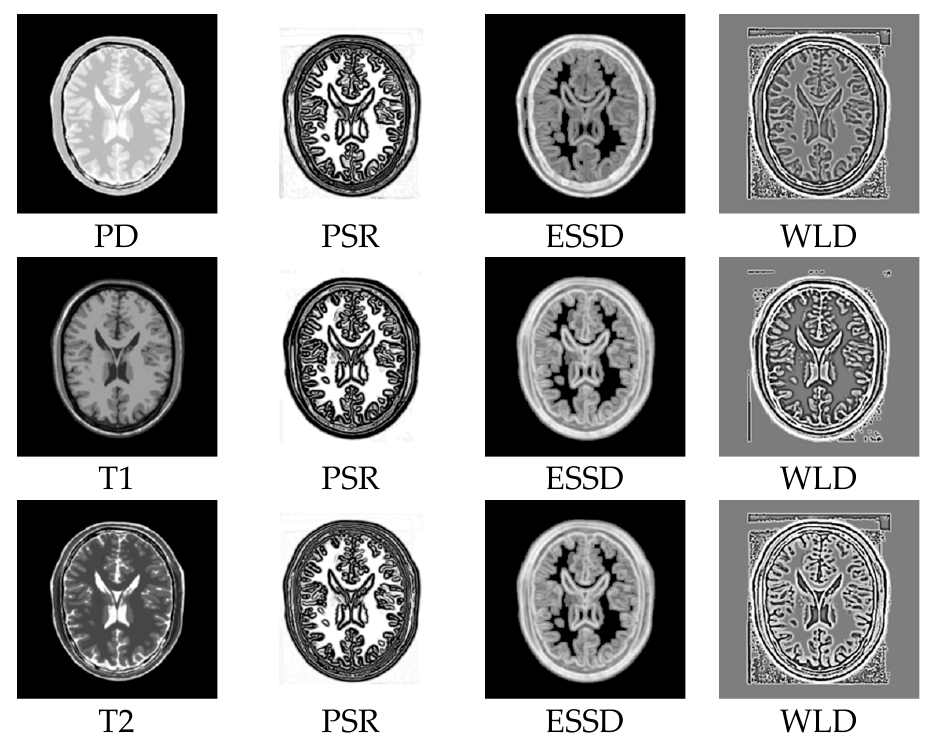
Figure 8. Structural representation results of different MR images. The first column corresponds to the PD-weighted, T1-weighed, and T2-weighed MR images, respectively. The second to fourth columns correspond to the representation results of MR images for PSR, ESSD, and WLD, respectively.